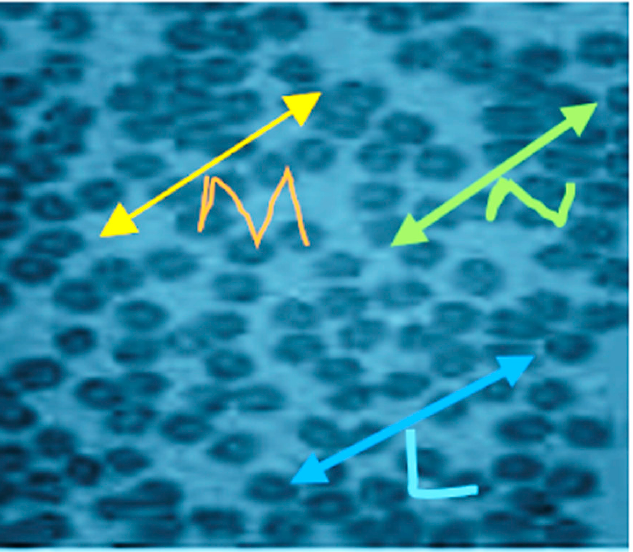
Figure 3. Photomicrograph of the blood cells of control fish 0.00 mg/L Nittol showing monocytes M, neutrophils N and lymphocytes L.